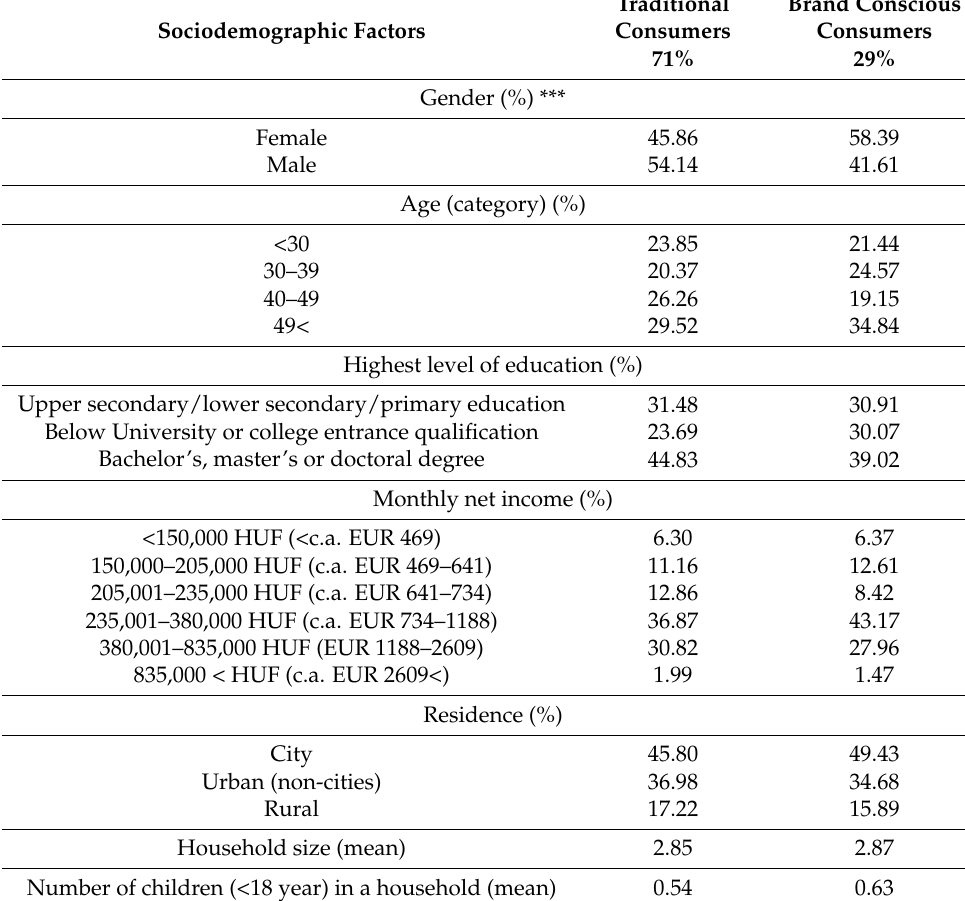
Table 7. Sociodemographic characteristics of classes based on the latent class model.